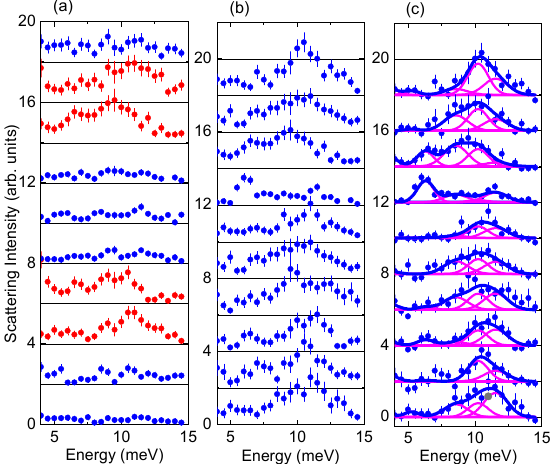
Figure 1. Zone center phonon data obtained from measured S ( Q , ω ) of Ba 8 Ga 16 Ge 30 . The binning was ∆ H = ∆ K = ∆ L = ± 0.1 reciprocal lattice units (r.l.u.). The wavevectors (H,K,L) in order from top to bottom are: ( a ) Q = (2, − 1, − 3), ( − 2, − 1, − 7), ( − 2, − 1 − 9), ( − 4,0 − 11), ( − 4,0, − 3), ( − 4,0, − 4), ( − 4,0, − 6), ( − 1,0, − 10), ( − 10, − 9,2), ( − 7, − 9,3); For ( b , c ): Q = ( − 9, − 10, − 4), ( − 8, − 7, − 10), ( − 7, − 8, − 9), ( − 1, − 4, − 3), ( − 10, − 9,2), ( − 3, − 4, − 9), ( − 5, − 9, − 8), ( − 6, − 8, − 9), ( − 7, − 10, − 2), ( − 1,0, − 10). ( a , b ) data points represent raw data. ( c ) data points represent background-subtracted data. Magenta curves represent individual phonon peaks determined through the multizone fit. Blue curves are fit results. Peak positions based on the fit are: 5.3 ± 0.1, 6.3 ± 0.1 8.6 ± 0.15, 10.2 ± 0.1, and 11.6 ± 0.2 meV.